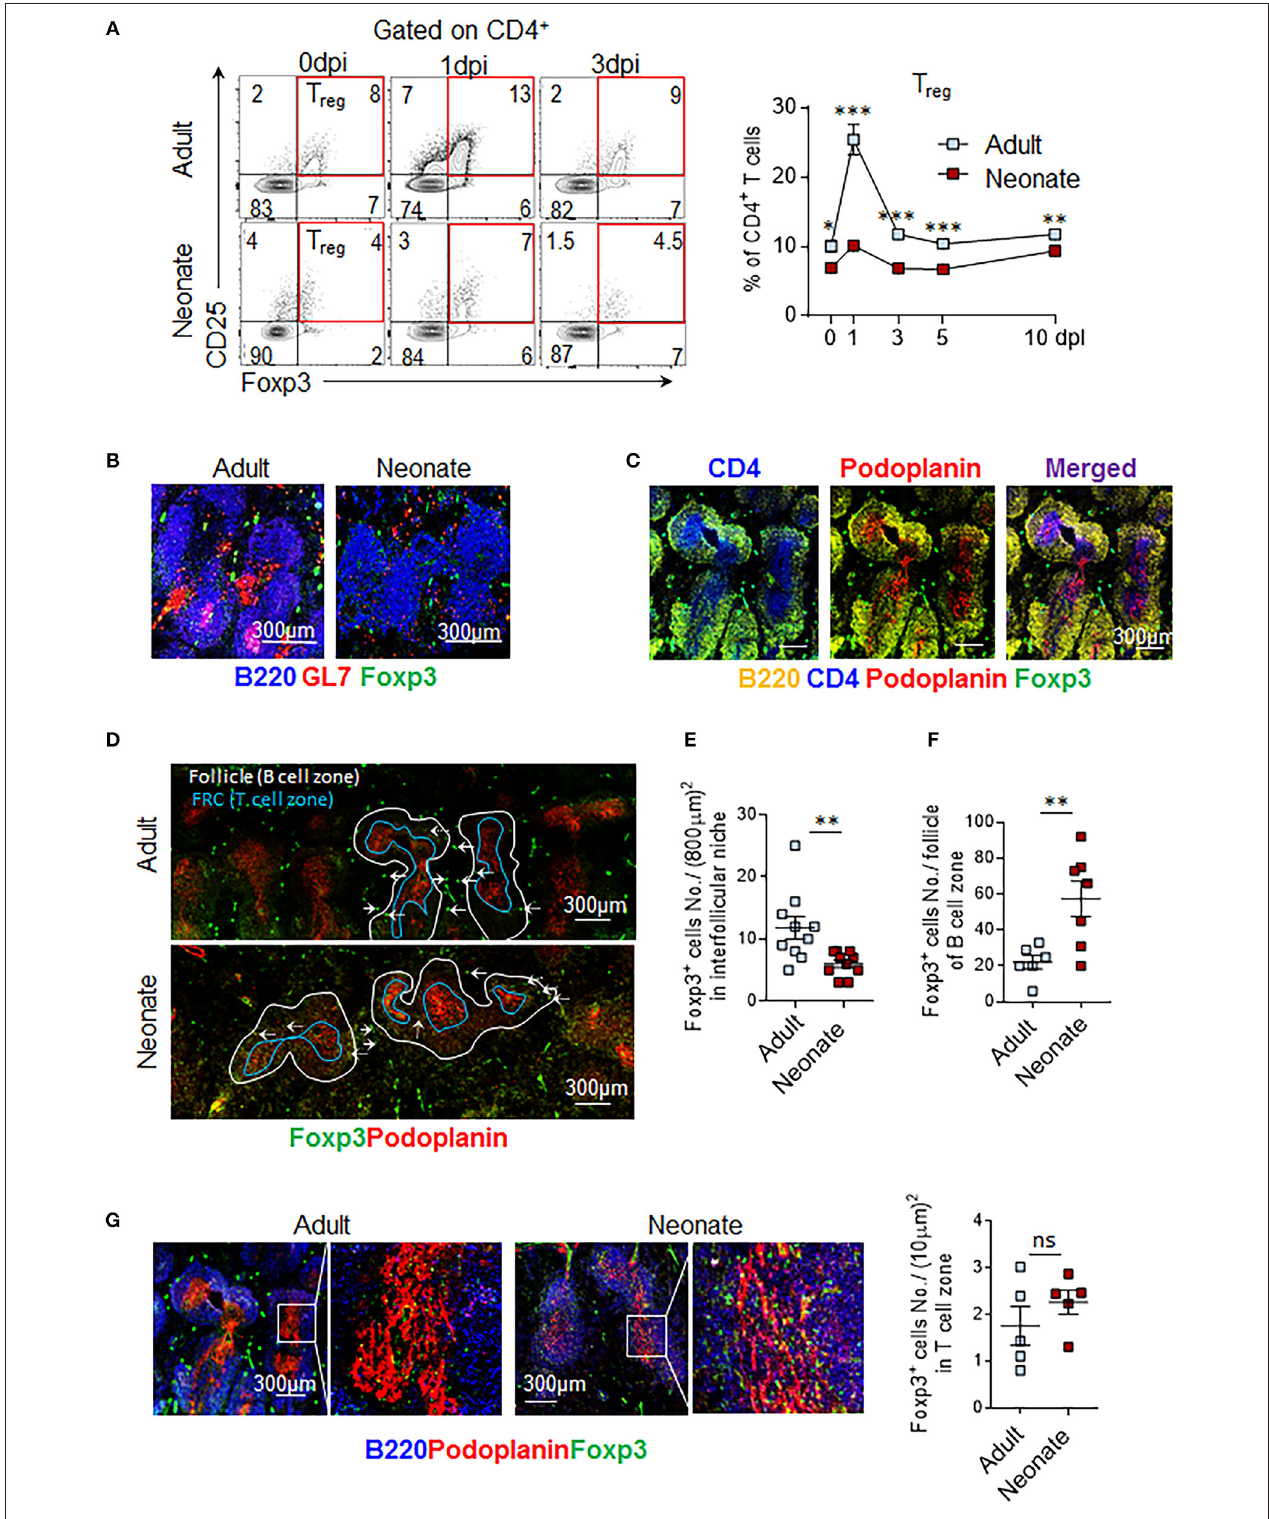
FIGURE 4 | T reg cells populate interfollicular niches in adult, and follicles in neonatal spleen. Adult (6 to 10-week-old) and neonatal (5 day-old) mice were immunized i.p. with SRBC. (A) Representative dot plots of T reg (CD4 + CD25 + Foxp3 + ) cells from 0, 1, and 3 dpi are shown. Mean percentages of T reg cells among CD4 + cells